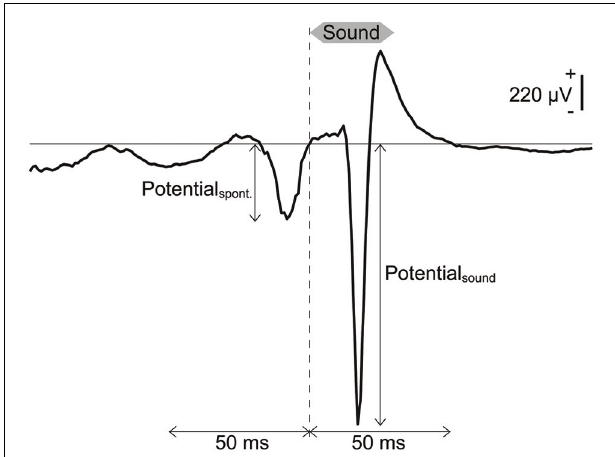
FIGURE 2 | Transient activities in response to pure tones based on LEPs. Representative LFP obtained from a pure tone burst with a frequency of 50 kHz and an intensity of 70 dB SPL. Spontaneous potentials and AEPs were quantified as the absolute values of the minimum peak in the 50-ms LFPs preceding and following the onset of each pure tone burst.